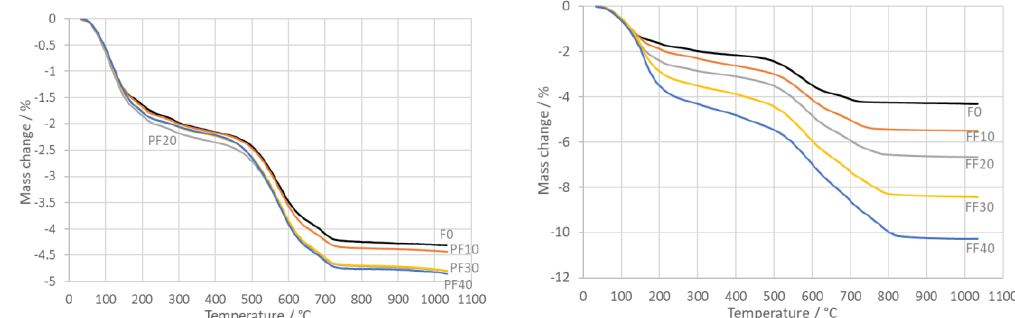
Figure 2. The mass change of PF ( left ) and FF ( right ) samples.